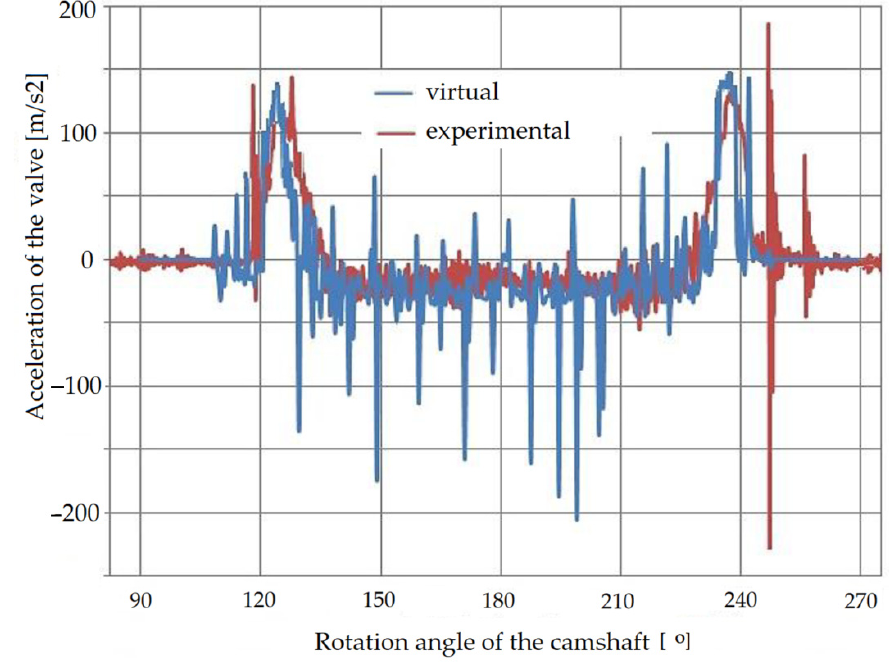
Figure 13. Valve acceleration for n AD = 750 rpm.